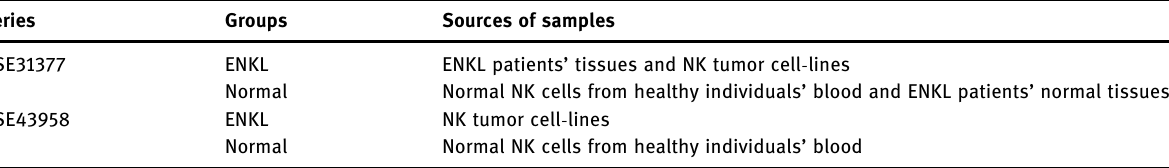
Table 1: Sample grouping of GSE31377 and GSE43958 for DE - miRNA identi fi cation Series